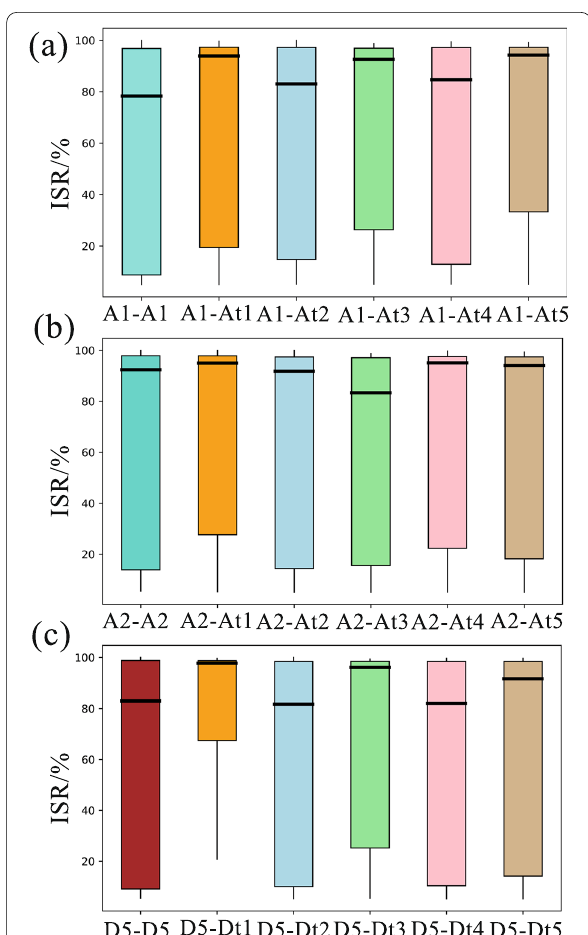
Fig. 2 Identical site rate (ISR) in Rho proteins across 8 cotton species. a . Identical site rate of Rho proteins from G. herbaceum and 5 tetraploids. A 1 -A 1 means all Rho proteins from G. herbaceum. The A 1 -A t indicates all mixed Rho proteins from both G. herbaceum and the corresponding A t sub-genome from tetraploid. b Identical site rate of Rho proteins from G. arboreum and 5 tetraploids. A 2 -A 2 means all Rho proteins from G. arboreum . The A 2 -A t indicates all mixed Rho proteins from both G. arboreum and the corresponding A t sub-genome from tetraploid. c Identical site rate of Rho proteins from G. raimondii and 5 tetraploids. D 5 -D 5 means all Rho proteins from G.raimondii. The D 5 -D t indicates all mixed Rho proteins from both G. raimondii and the corresponding D t sub-genome from